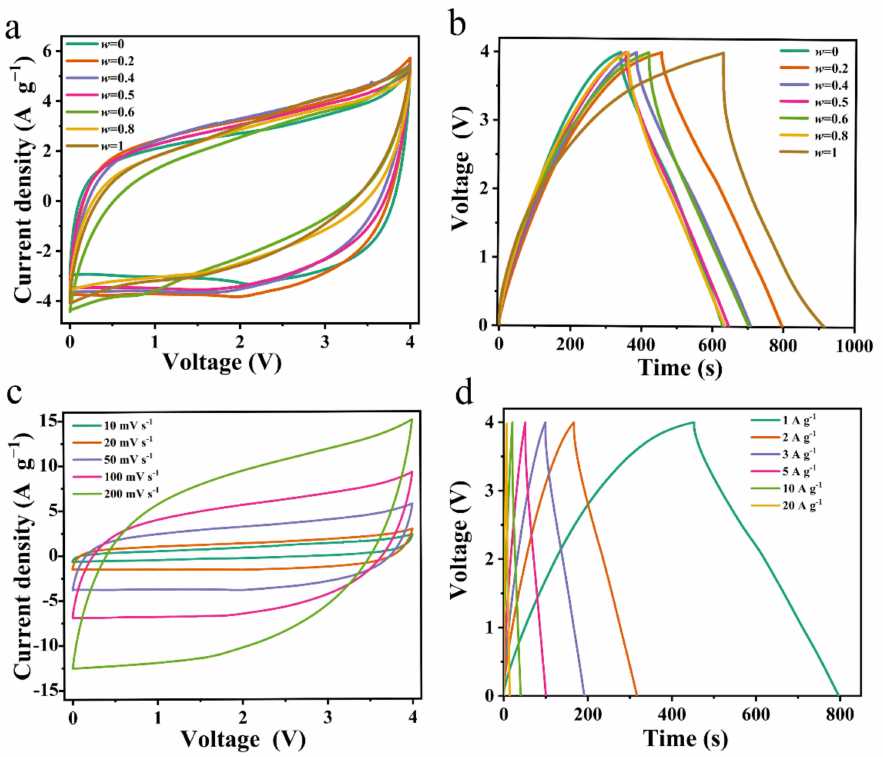
Figure 2. Electrochemical performance of [Bmim][TFSI] w [Emim][BF 4 ] 1 -w electrolyte at 30 ◦ C: ( a ) CV curves at 50 mV S − 1 and ( b ) GCD curves at 1 A g − 1 . ( c ) CV and ( d ) GCD curves in